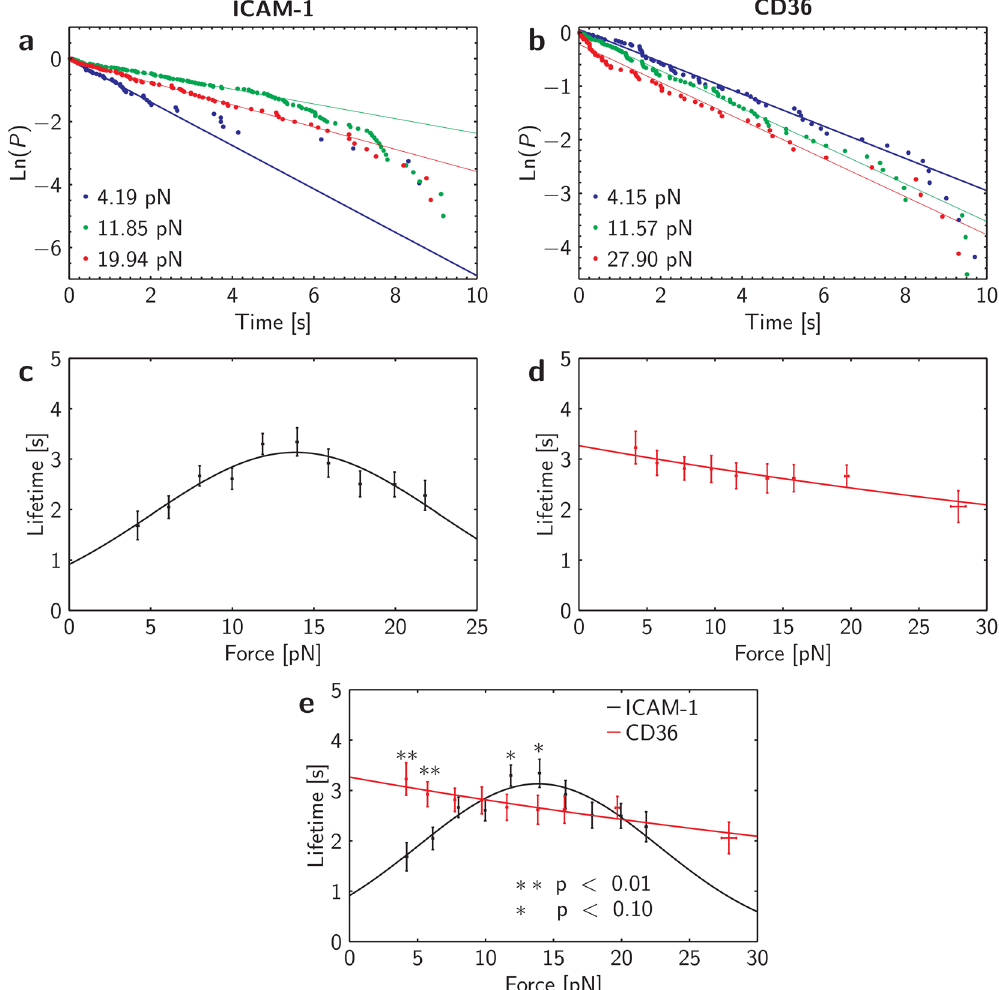
Figure 2. Single bond force spectroscopy results. Panels a and b: Survival probability plots of iRBC-ICAM-1 and iRBC-CD36 bonds respectively. Panels c and d: Lifetime against force graphs of iRBC-ICAM-1 and iRBC-CD36 interactions fitted to the catch and slip bond models. Lifetimes are represented as mean ± SEM. Panel e: Combined plots of panels c and d. Student’s t-test was conducted to compare the lifetimes of the two interactions within each force bin ( ** p < 0.01, * p <